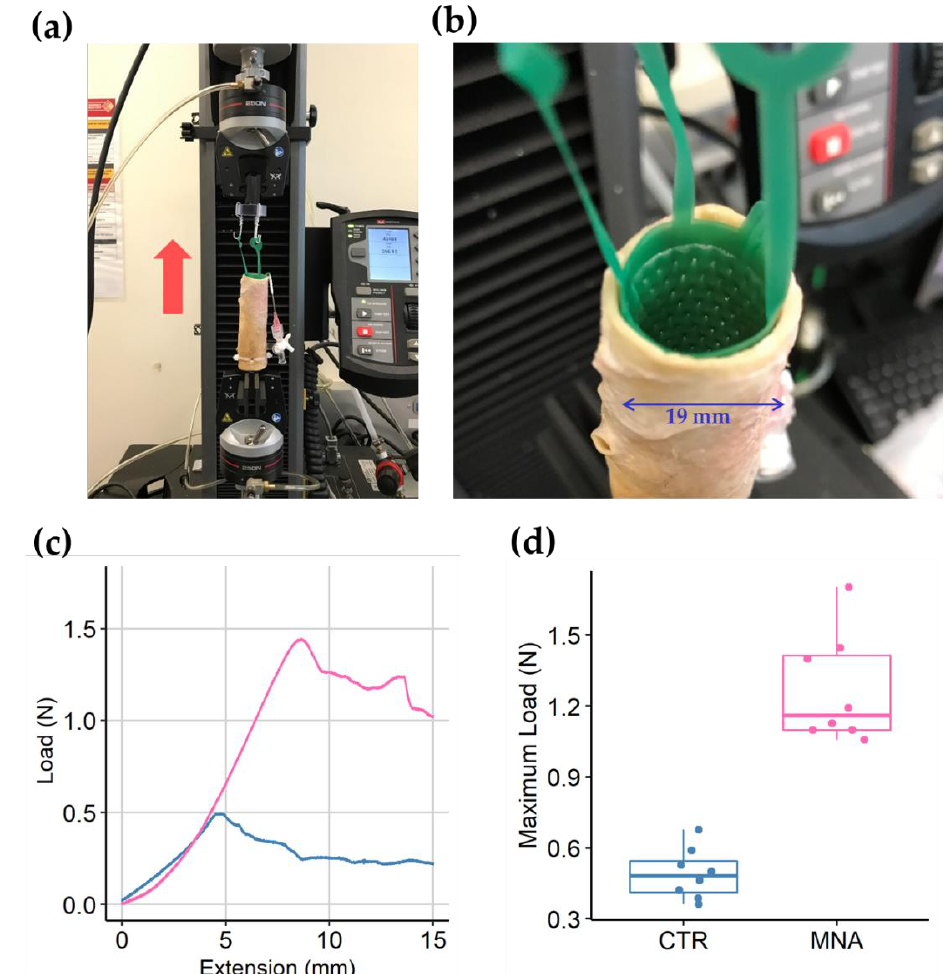
Figure 6. Anchorage tests for microneedle-patterned stents in a porcine aorta. ( a ) Tensile test setup on the Instron machine with vertically located aorta and stent; ( b ) Pressurized stent with linkers for the extension test; ( c ) Plot of continuously measured load during 15 minutes pull-out at 1 mm / min extension rate; ( d ) Box plot for maximum load applied during the test on control (CTR) and microneedle-attached (MNA) stents.